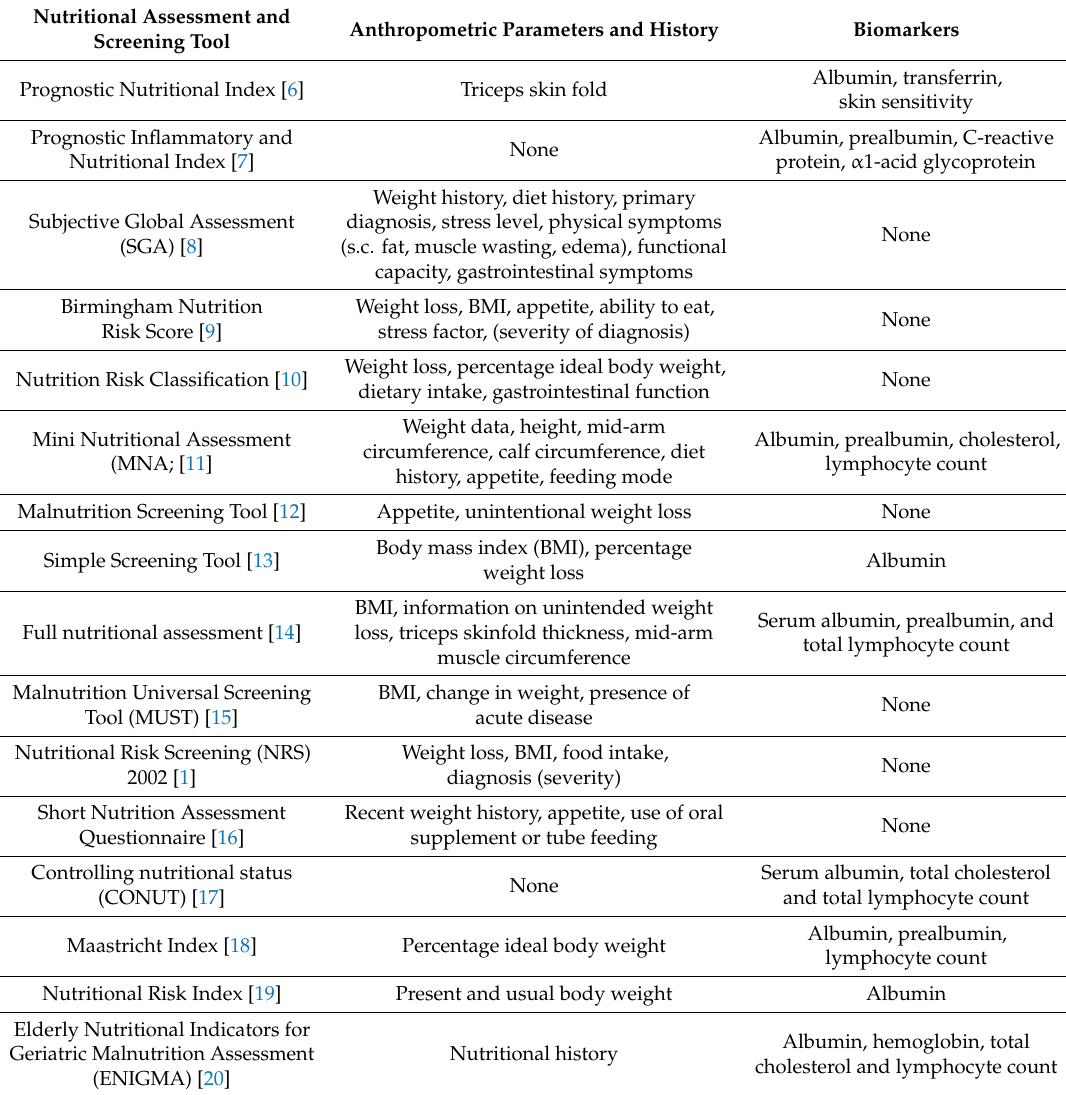
Table 1. Anthropometric parameters and biomarkers in various nutritional assessment and screening tools (adapted from [3] with an update, in chronological order of